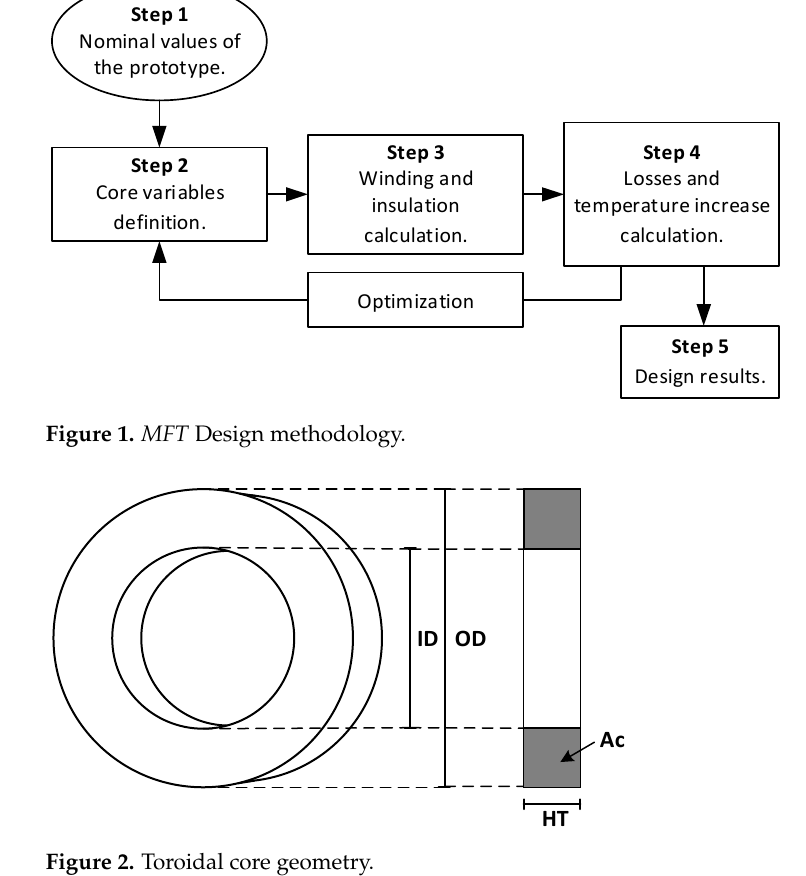
Figure 2. Toroidal core geometry.